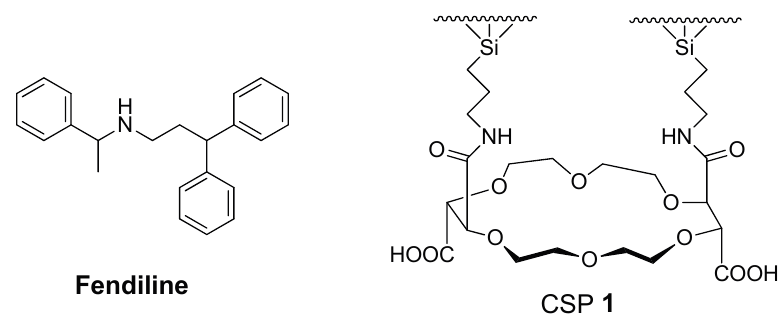
Figure 1. Structures of fendiline and chiral stationary phase (CSP) 1